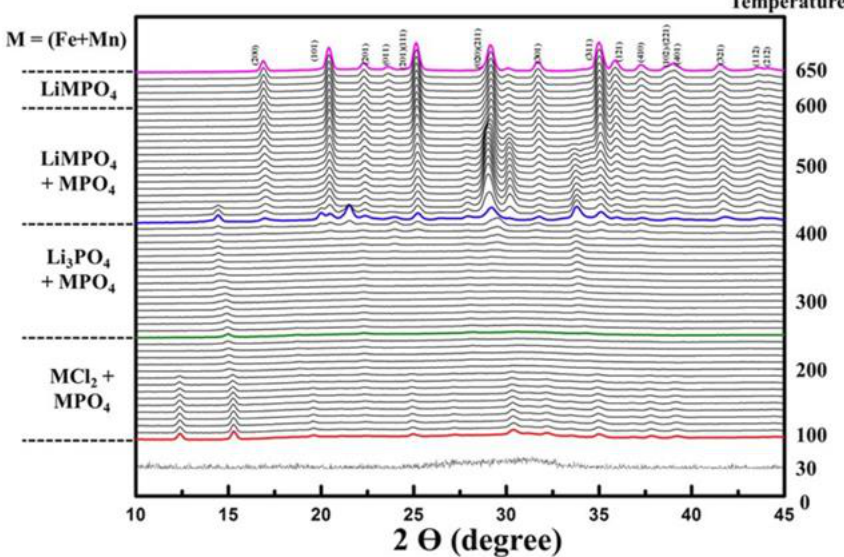
Figure 22. In-situ X-ray diffraction patterns of the Li-Mn-Fe-PO 4 /GO precursor prepared using the metal chlorides heated from 100 to 650 °C in an inert atmosphere [18], with permission from Springer Nature.